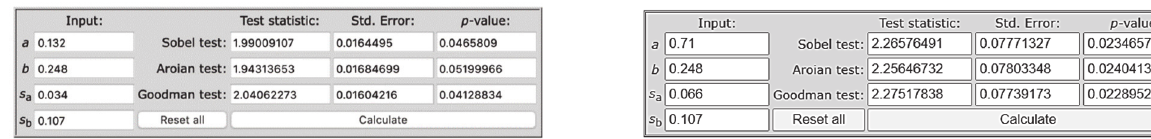
Fig. 3. Sobel Calculator 1 Fig. 4. Sobel Calculator